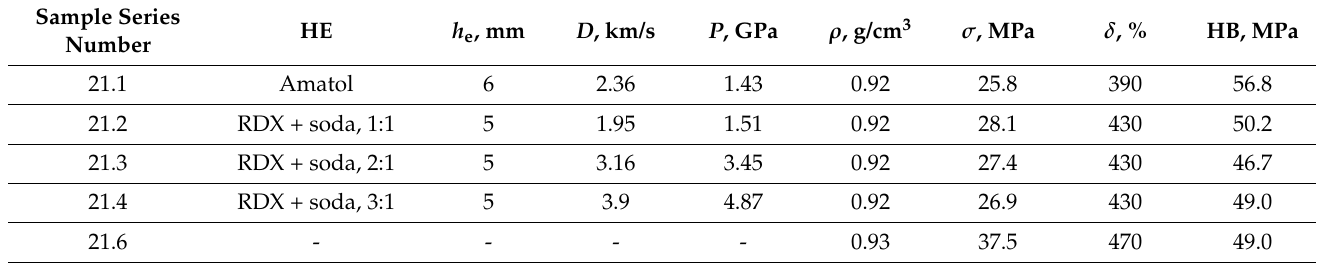
Table 3. Parameters of UHMWPE powder activation by explosion and properties of compacts made from activated powder by CIC: h e , the thickness of the HE charge; D , the detonation velocity of HE; P , pressure behind the detonation front; ρ , compact density; σ , compact tensile strength; δ , elongation; HB, compact Brinell